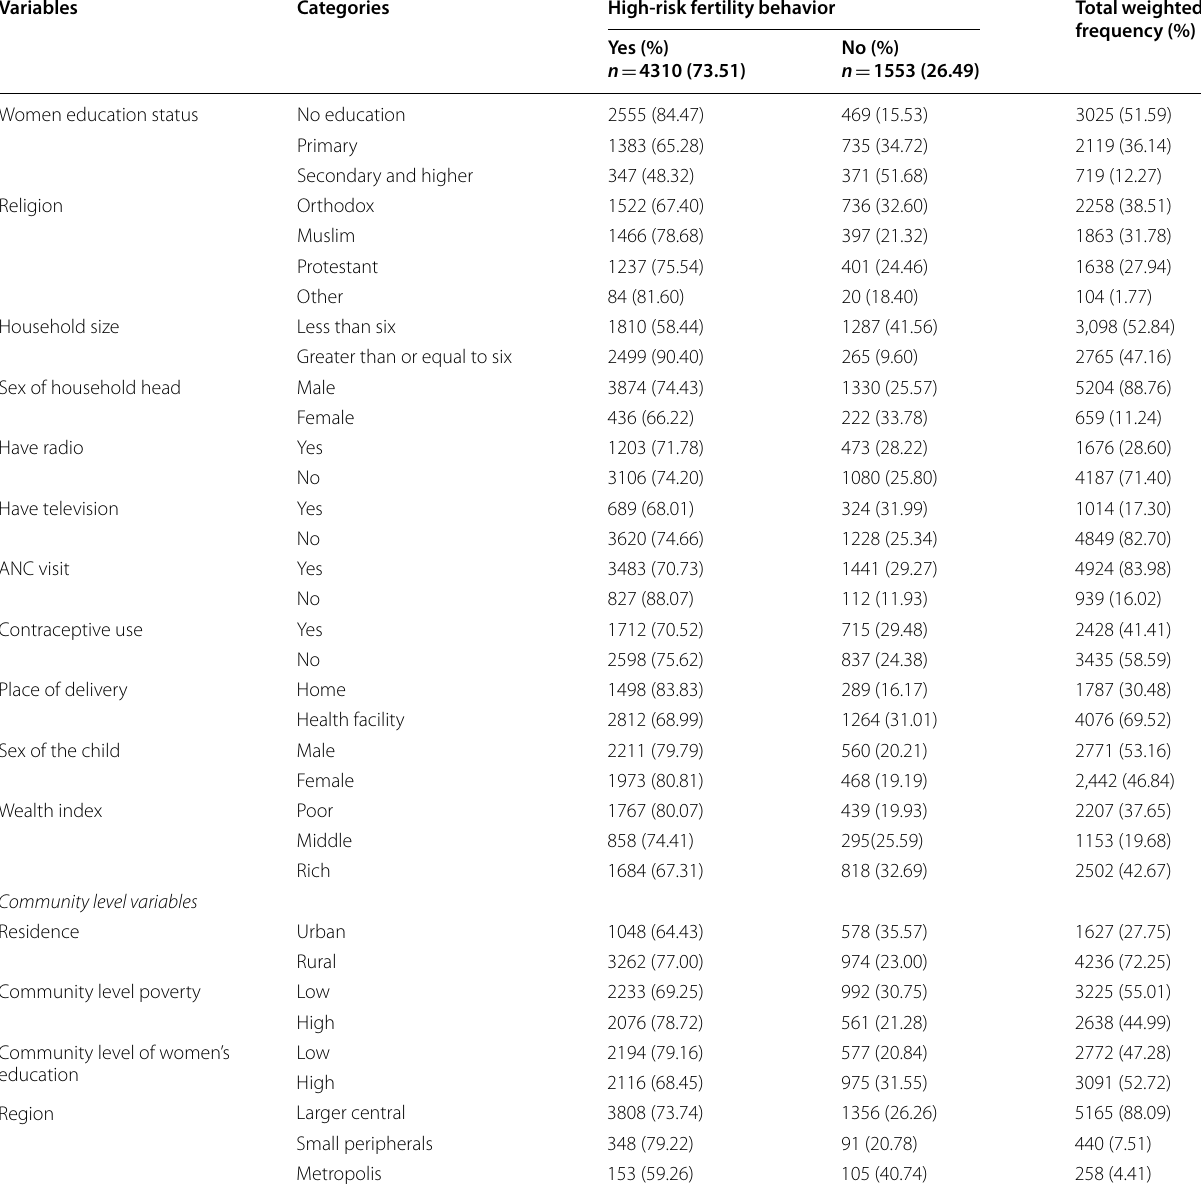
Table 1 Characteristics of the study population with high-risk fertility behavior among reproductive-age women in Ethiopia